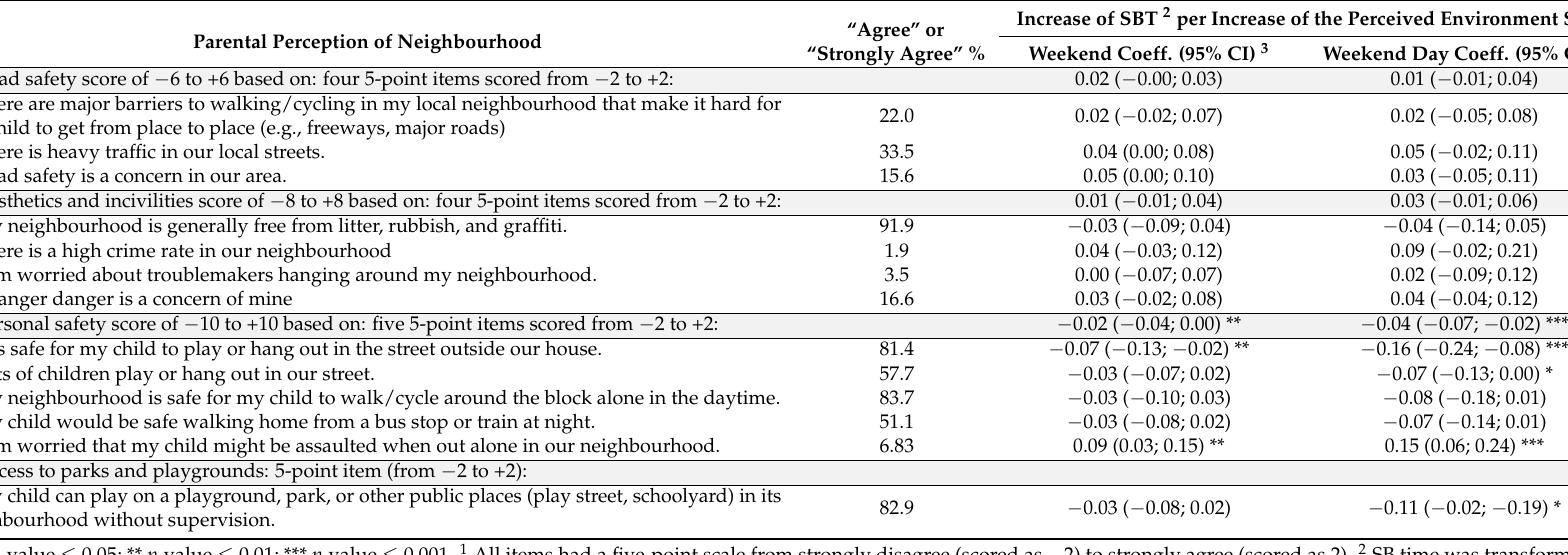
Table 2. Independent associations of the perceived neighbourhood 1 with sedentary time on weekdays and the